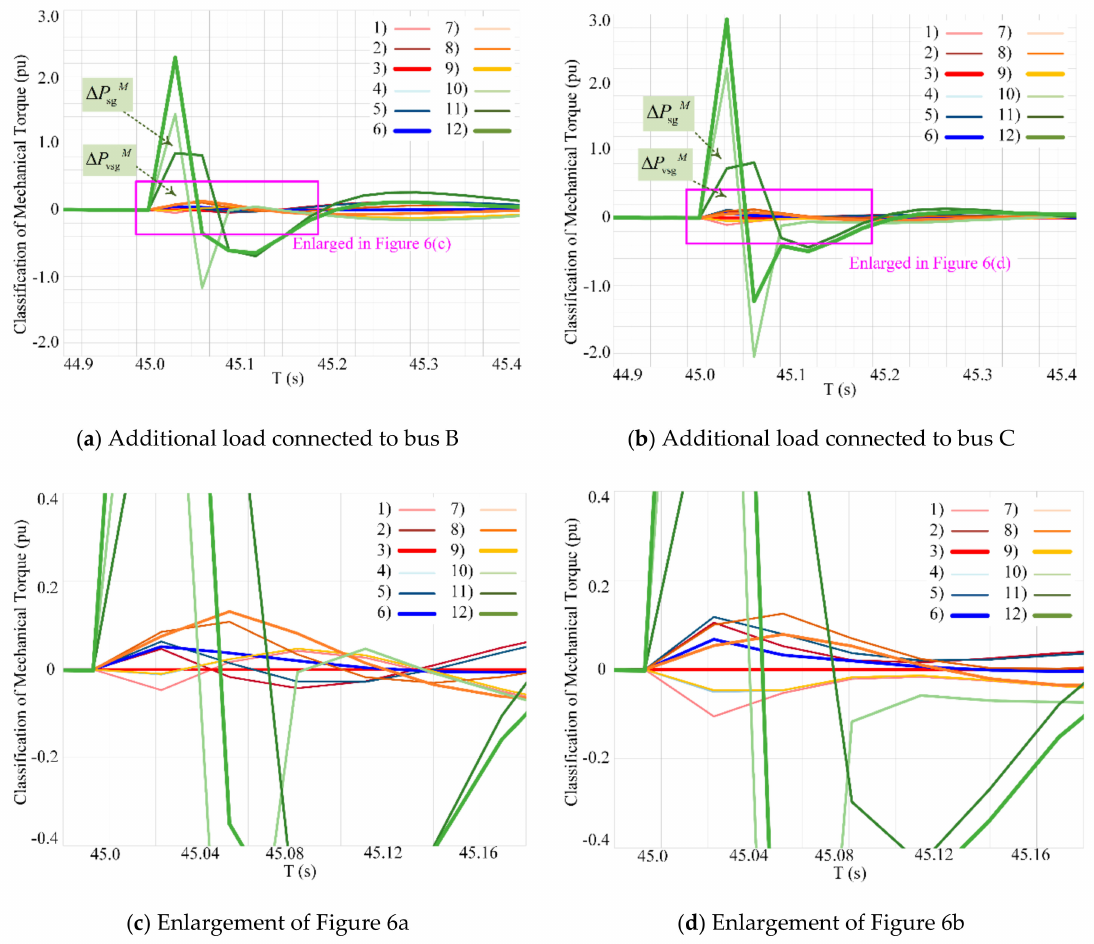
Figure 6. Classification of the mechanical torque: for SG and VSG, respectively, ∆ P sg D and ∆ P vsg K are synchronization torques, ∆ P sg D and ∆ P vsg D are dumping torques, ∆ P sg R and ∆ P vsg R are torques based on the governor effects, and ∆ P M and ∆ P M are inertial torques. (1) ∆ P K , (2) ∆ P K , (3) ∆ P K + ∆ P K , (4) ∆ P K + ∆ P D , (5) ∆ P K + ∆ P D , sg vsg sg vsg sg vsg sg sg vsg vsg (6) ( ∆ P sg K + ∆ P sg D ) + ( ∆ P vsg K + ∆ P vsg D ) , (7) ∆ P sg K + ∆ P sg D + ∆ P sg R , (8) ∆ P vsg K + ∆ P vsg D + ∆ P vsg R , (9) ( ∆ P sg K + ∆ P sg D + ∆ P R ) + ( ∆ P K + ∆ P D + ∆ P R ) , (10) ∆ P K + ∆ P D + ∆ P R + ∆ P M , (11) ∆ P K + ∆ P D + ∆ P R + ∆ P M , sg vsg vsg vsg sg sg sg sg vsg vsg vsg vsg (12) ( ∆ P sg K + ∆ P sg D + ∆ P sg R + ∆ P sg M ) + ( ∆ P vsg K + ∆ P vsg D + ∆ P vsg R + ∆ P vsg M )